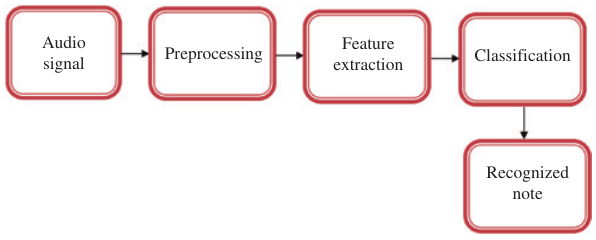
Figure 1: Block Diagram of the Proposed